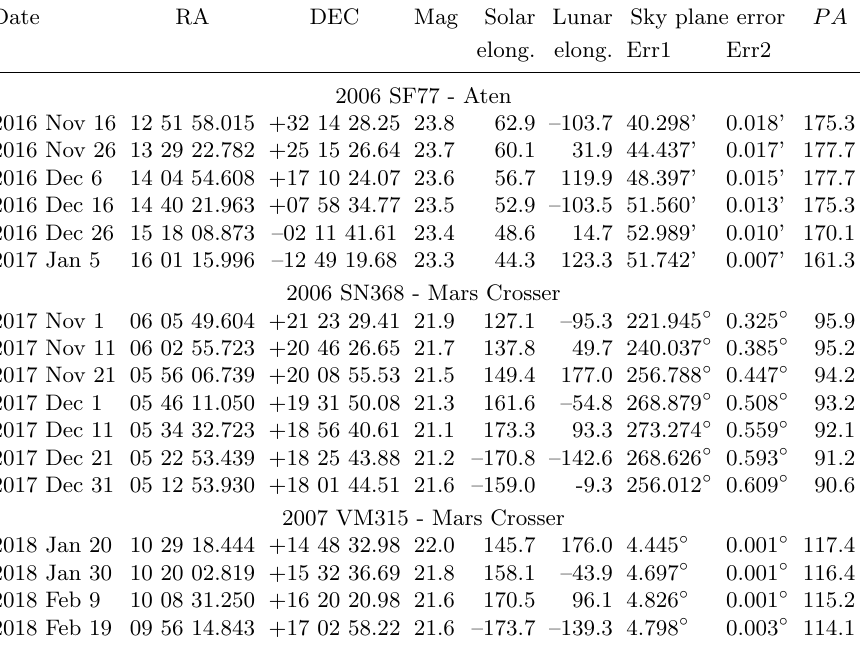
Table 4. Ephemerides for 2016{2018 of the asteroids with dynamically interesting or- bits of low accuracy discovered at the Mol_etai Observatory (for the geocentric